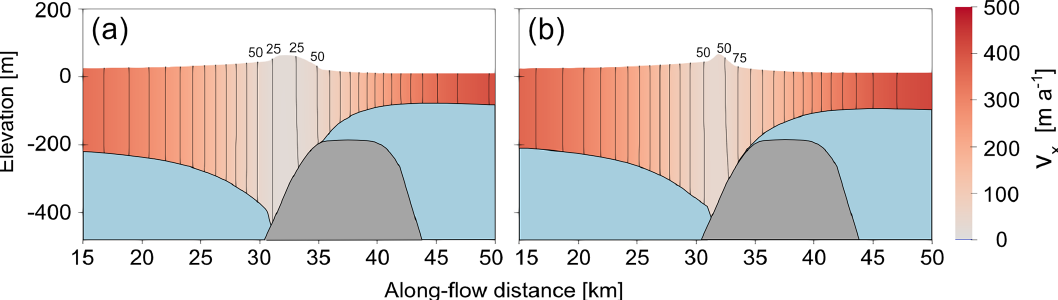
Figure 12. An along-flow cross-section of the ice rumple at t = 8000 years in the case of (a) the low-basal-friction and (b) the intermediate- basal-friction scenario. The contours show lines of equal velocity in the x direction and are spaced 25ma − 1 apart.